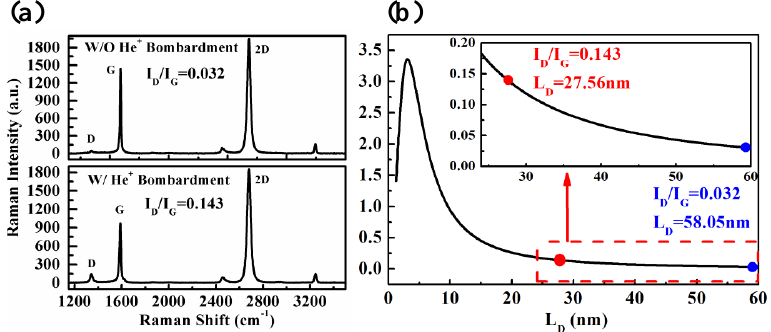
Figure 7. ( a ) Raman spectra of the graphene in G-M contact windows with/without He + bombardment before metal depositions; ( b ) The calculated relationship between I D /I G and mean defect distance (L D ).